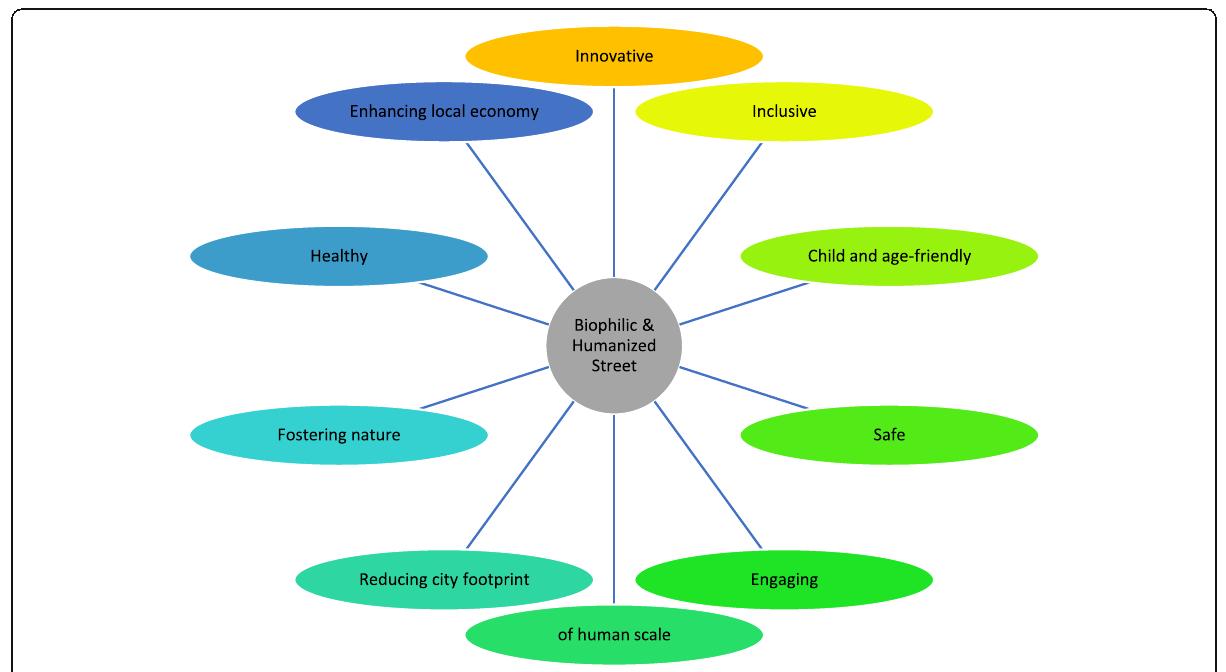
Fig. 6 The multiple urban benefits of a Biophilic